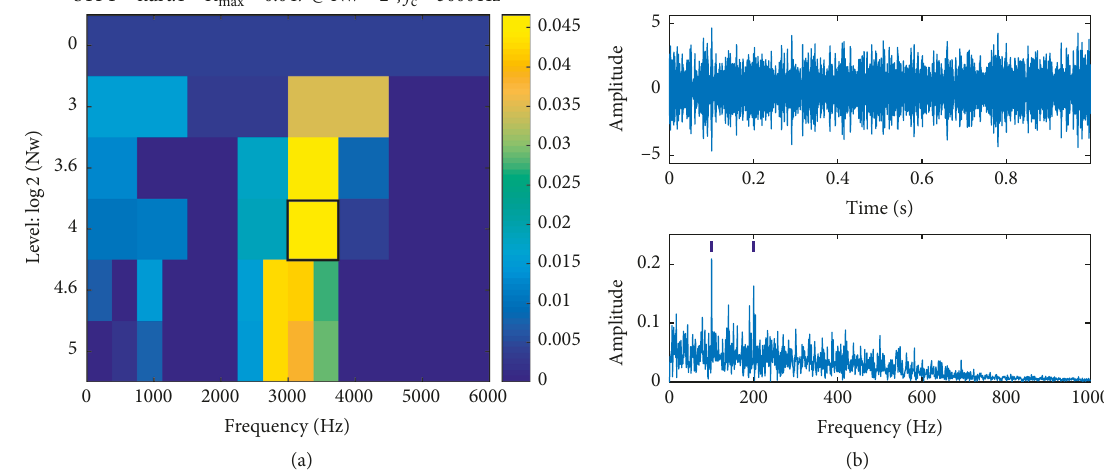
Figure 8: (a) Fast kurtogram based on STFT; (b) signal component and its envelope sequence.